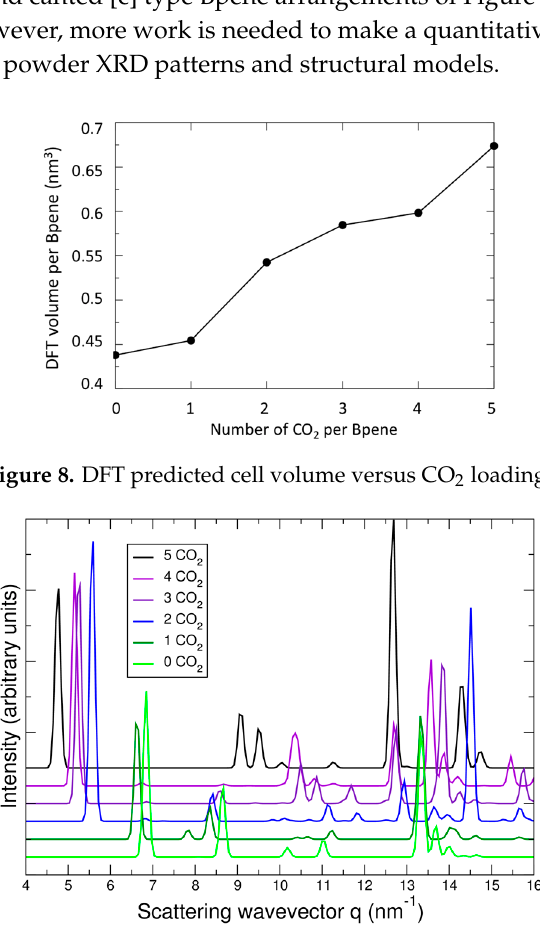
Figure 10. Predicted geometry of CO 2 at loading of five CO 2 per Bpene, projected along ( a ) the ab plane and ( b ) the ca plane. CO 2 molecules are magnified for clarity. Element key: gold = Ni, white = H, blue = N, green = C, red = O. Also see Figure 1.